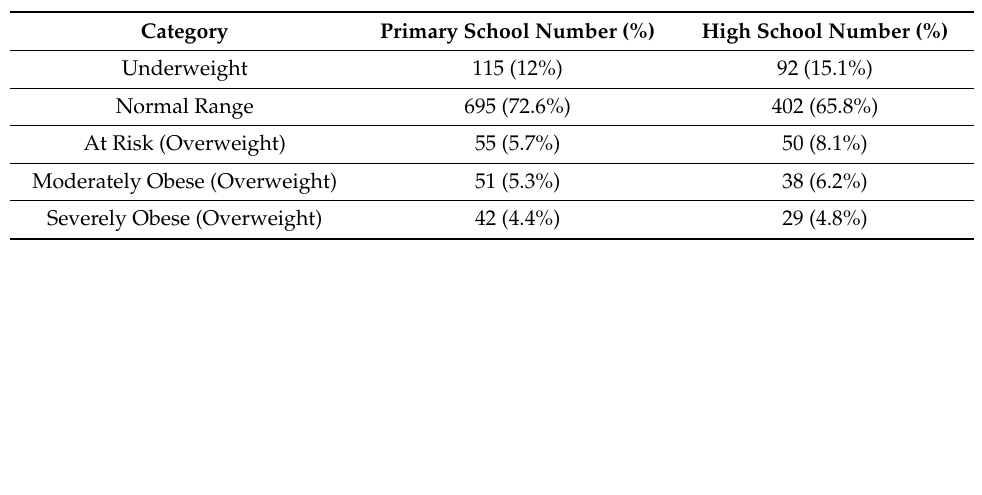
Table 2. Body mass index (BMI)